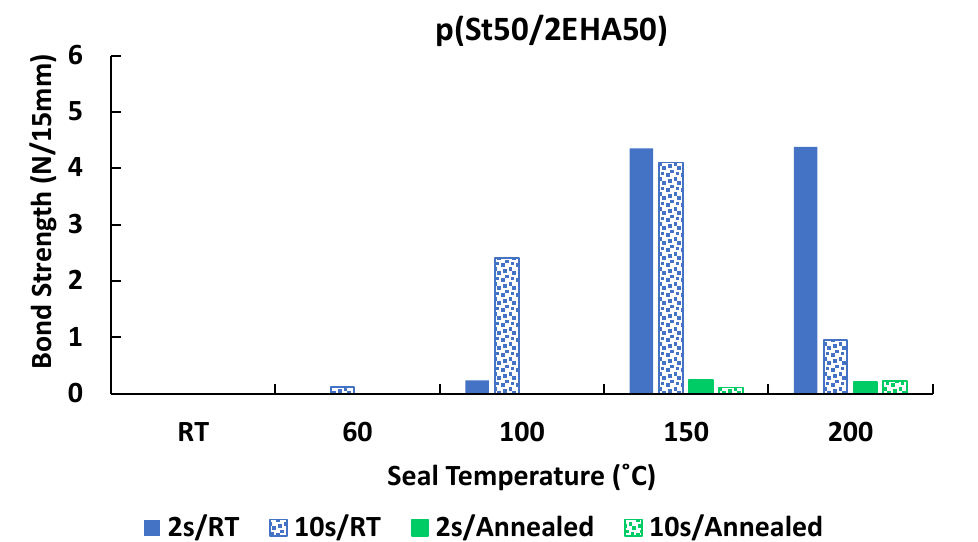
Figure 11. Bond strength of hard-soft AB block copolymer dispersions coated on paper (paper-to-paper seal). Sealing experiments done at dwell times of 2 s and 10 s. Coating preparations: RT = coated papers where dried at room temperature; annealed = coated papers where in addition stored at 100 °C overnight.